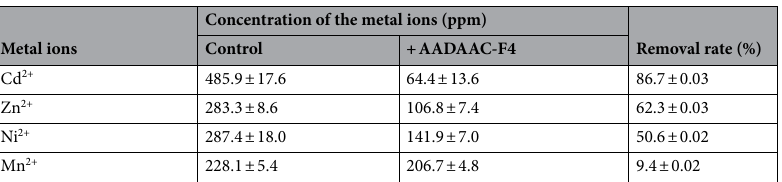
Table 4. The removal rate of various metal ions with the peptide treatment determined by ICP-MS measurement. Mean removal rates with SE are shown in the table. Equal molar amounts of peptides and metal ions were dissolved in Tris–HCl buffer solution (50.0 mM Tris, 599 mM NaCl, pH 8.0). The measurements were repeated at least three